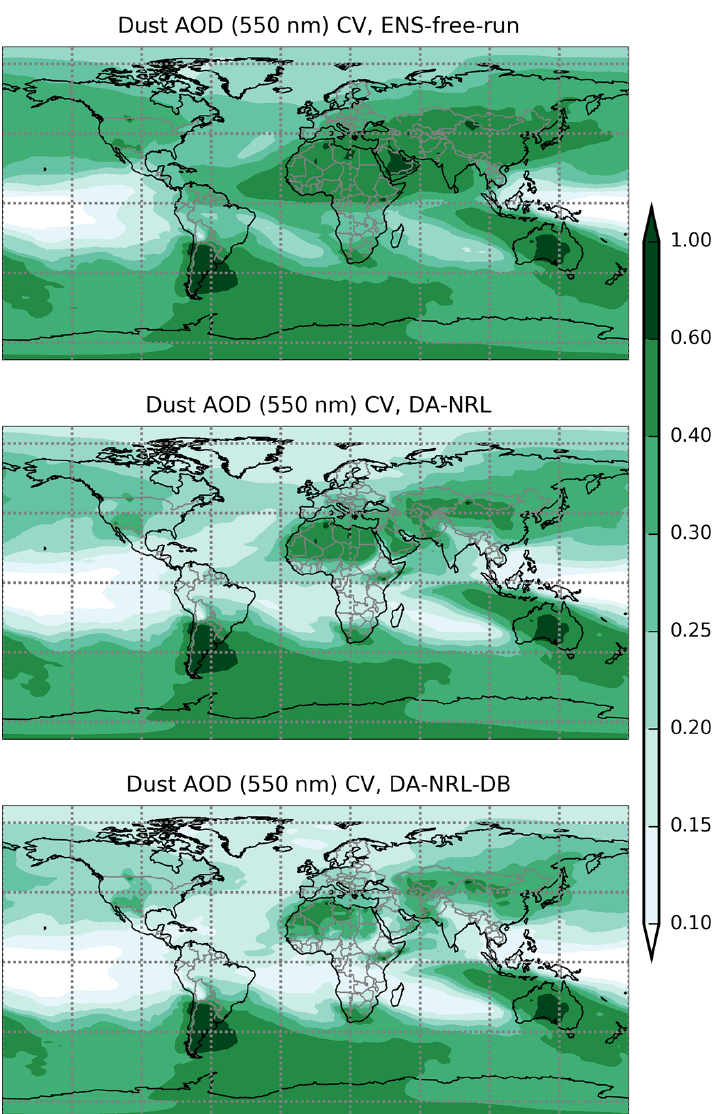
Figure 7. Coefficient of variation for the month of May 2007 for the ENS-free-run (top), DA-NRL (centre), and DA-NRL-DB (bottom) experiments, when the ensemble is created perturbing the emitted mass vertical flux for each dust bin and the threshold on the friction velocity generating dust horizontal